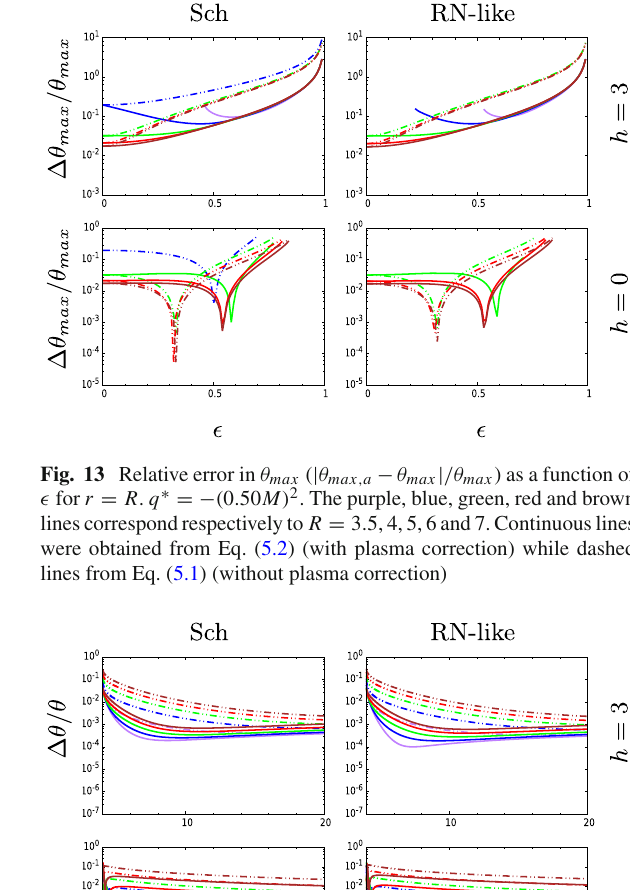
Fig. 14 Relative error in θ ( | θ a − θ | /θ ) as a function of the radius r along the marginal trajectory [ δ( R ) = π/ 2]. q ∗ = − ( 0 . 50 M ) 2 , R = 4 M . The purple, blue, green, red and brown lines correspond respectively to (cid:11) = 0 . 1, 0 . 2, 0 . 3, 0 . 4 and 0 . 5. Continuous lines were obtained from Eq. (5.2) (with plasma correction) while dashed lines from Eq. (5.1) (without plasma correction). At all times plasma